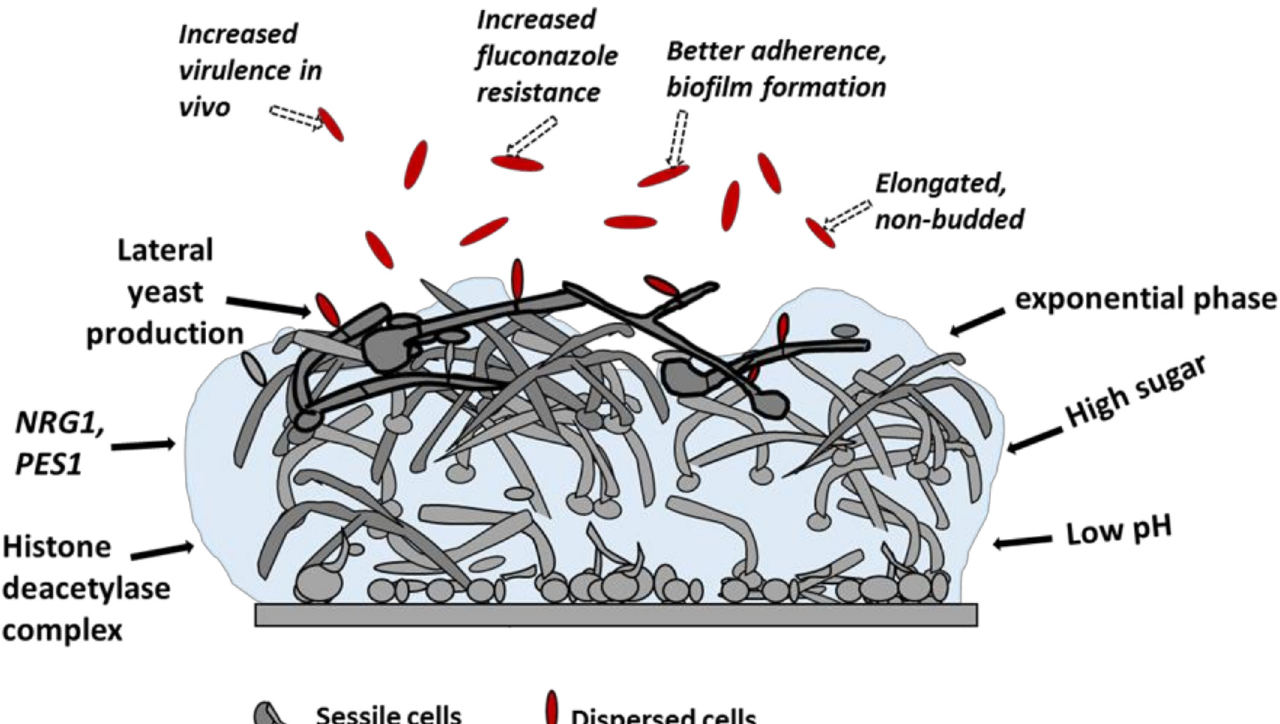
Fig 2. Biofilm dispersal in fungi ( C . albicans ). Biofilms are composed of basal parental yeast and germ tube cells, as well as a mesh of hyphal cells covered with EPS. Lateral yeast cells are composed of a large portion of elongated and virulent dispersed cells (dashed arrow), which are induced by a variety of external stimuli (block